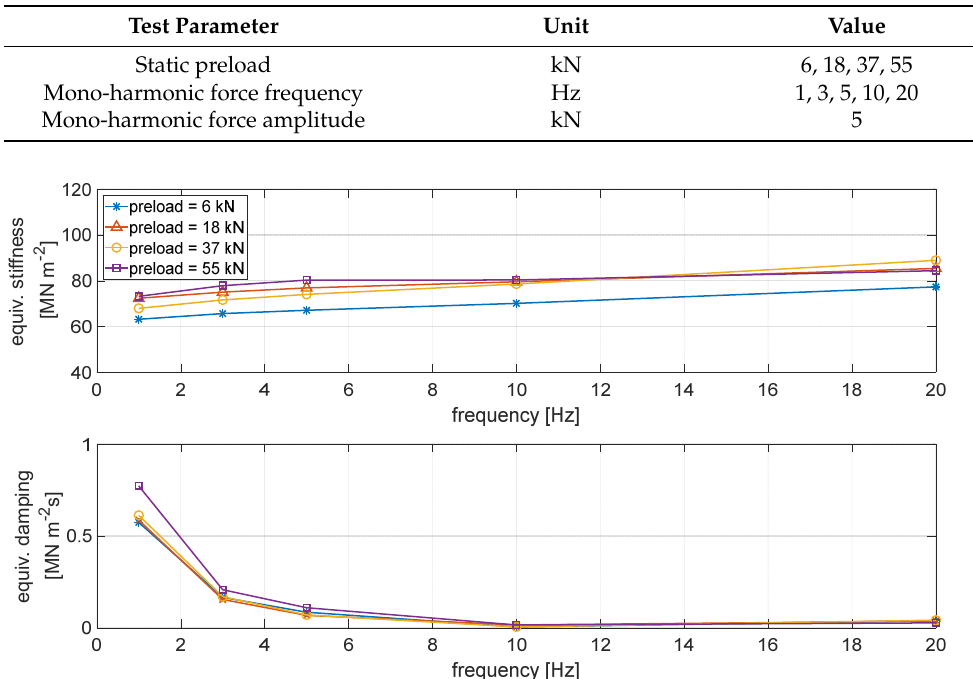
Figure 2. Test rig for full-scale experiments on a 750 mm long ERS sample to determine the dynamic behaviour in vertical direction. Red boxes: laser displacement transducers for vertical motion measurement. Yellow box: accelerometer for loading head acceleration measurement. Table 2. Parameters of the tests to determine the dynamic properties of the elastomeric materials in the vertical direction.